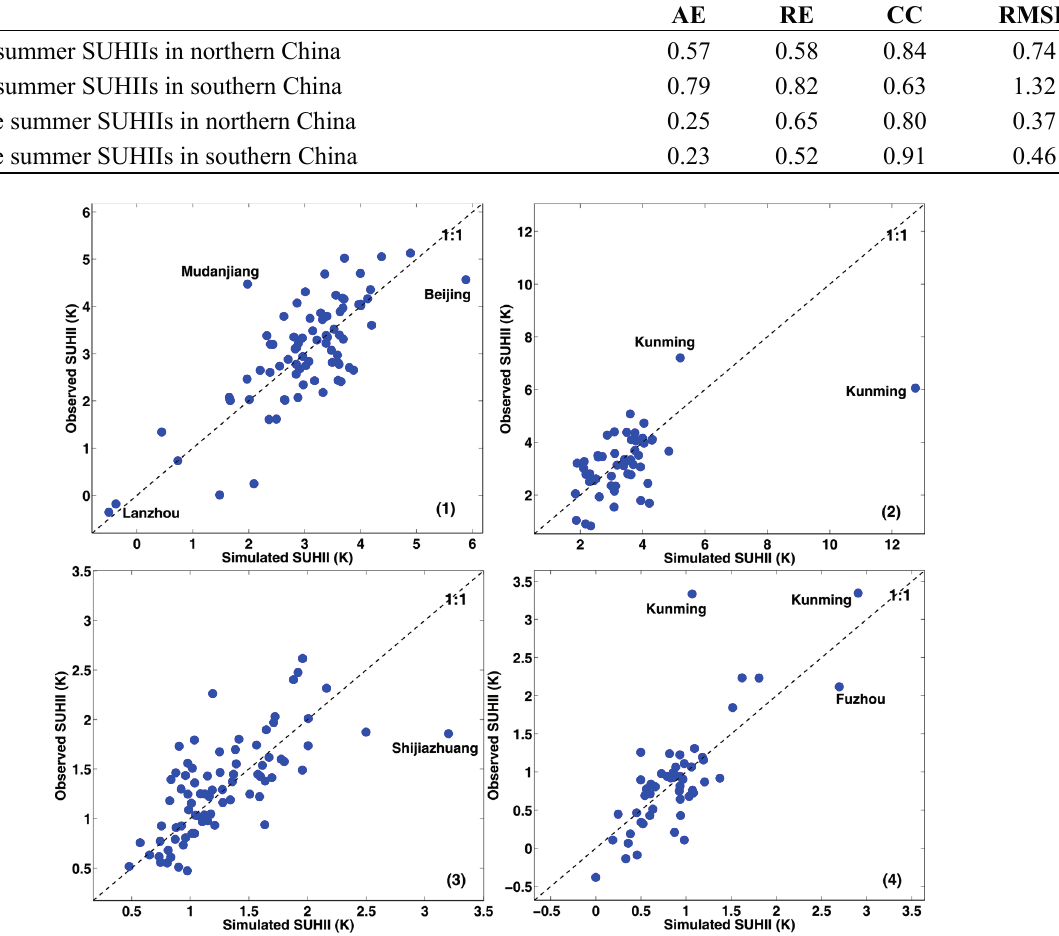
Figure 5. Scatterplots between the observed SUHIIs from the MODIS datasets and the simulated SUHIIs for model: ( 1 ) daytime summer SUHIIs in northern China; ( 2 )